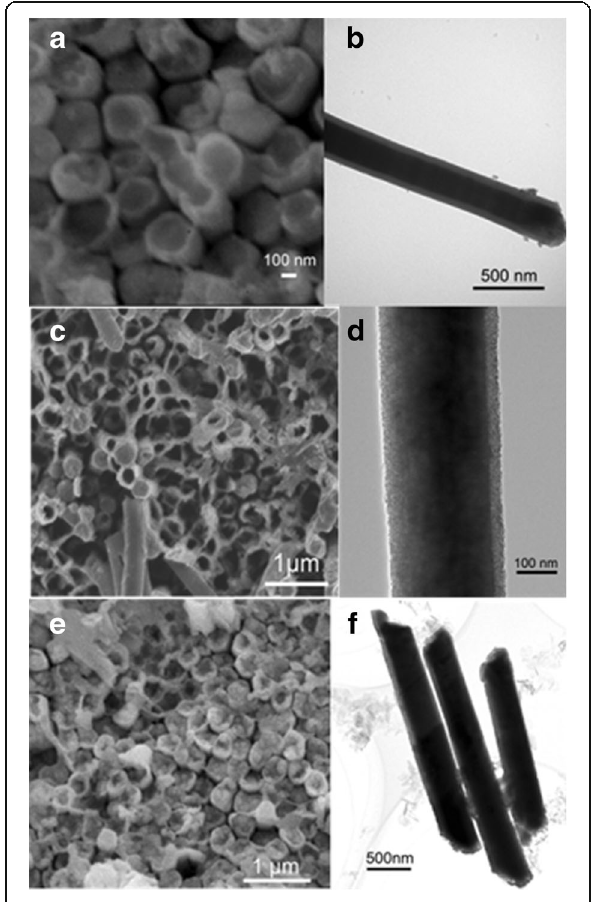
Fig. 4 X-ray diffraction patterns of Nd/Ni/PA66, Nd/Co/Pa66, and